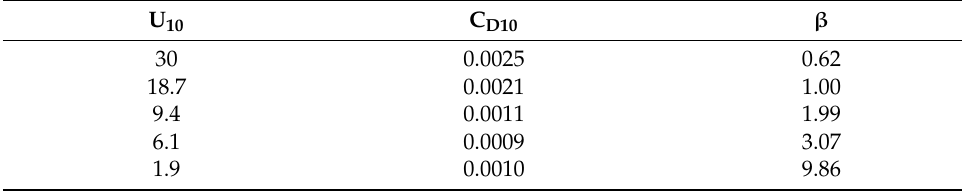
Table 2. Wind model characteristics of TEST_2 (T 12 s). U